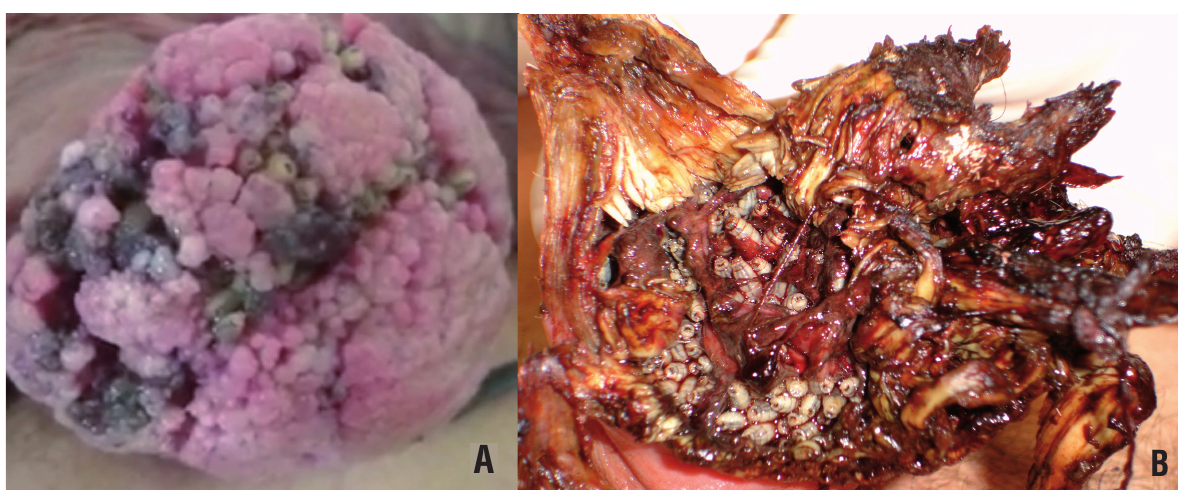
Figure 1 - Penile cancer associated to myiasis. A) 44 year-old patient with extensive lesion in penile shaft with secondary infection associated with myiasis infestation.